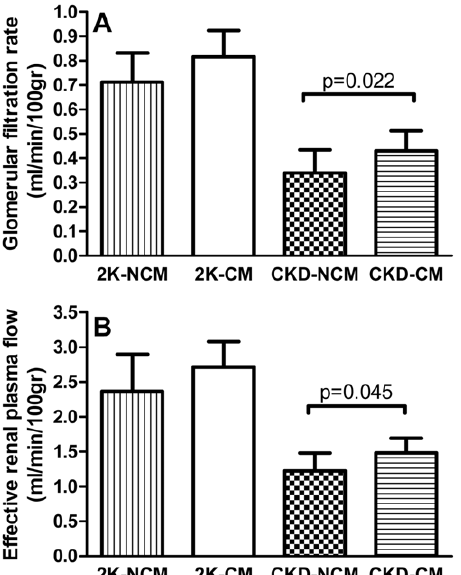
Figure 1. CM treatment increases kidney function. CM treatment increased glomerular filtration rate (GFR) (A) and effective renal plasma flow (ERPF) (B) in CKD. 2K-NCM (n=6); 2K-CM (n=6); CKD-CM (n=13); CKD-NCM (n=13). Post-hoc test p-value is shown.